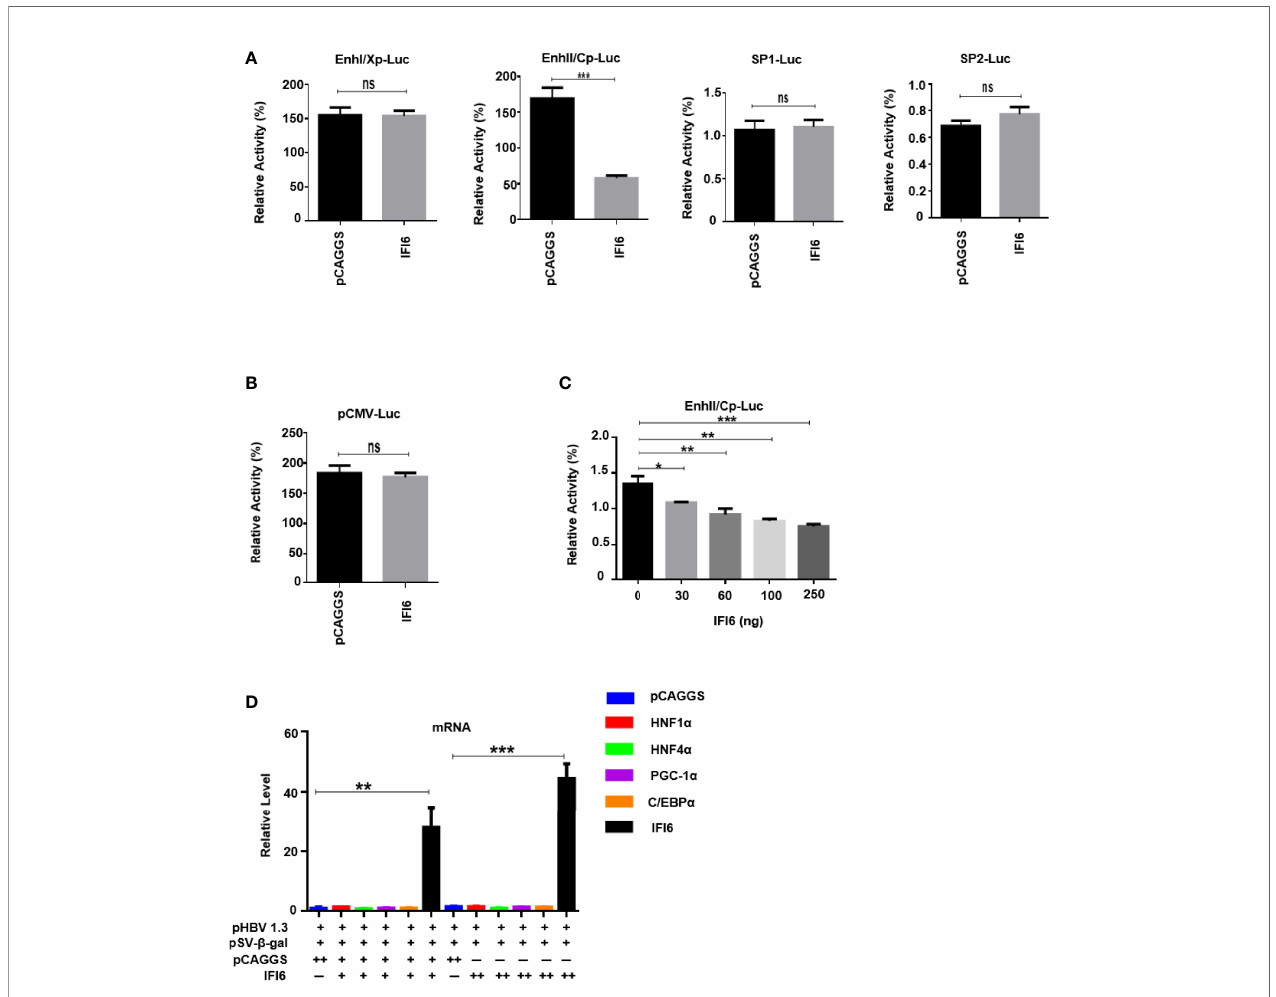
FIGURE 4 | IFI6 downregulate HBV gene expression by suppressing EnhII/Cp promoter activity. HepG2 cells, along with IFI6 expression plasmid or control plasmid (250 ng) was transiently transfected with four reporter plasmids (200 ng) in 24 well cell culture plates and harvested the cells after 48 hours of transfection and subjected to Dual-Luciferase assay. (A) The activity of four promoters was measured, and the pRL-TK (50 ng) was used as a transfection ef fi ciency control. (B) The activity of the pCMV promoter (200 ng) was measured with a Dual-Luciferase assay. (C) The activity of EnhII/Cp was measured in the indicated dose. (D) The level of different liver enriched transcription factors was measured by qRT-PCR. The + in pHBV1.3 showing 0.4 µg concentration, the + in pSV- b -gal showing 0.2 µg concentration, the + and ++ in pCAGGS and IFI6 indicate 0.2 and 0.4 µg concentration of pCAGGS and IFI6, respectively, and - in pCAGGS and IFI6 panel is showing zero concentration of pCAGGS and IFI6. The data are averages of three independent experiments; the results were measured as a mean ± SD and were statistically measured. *p < 0.05, **p < 0.01, *** P < 0.001, ns, non-signi fi